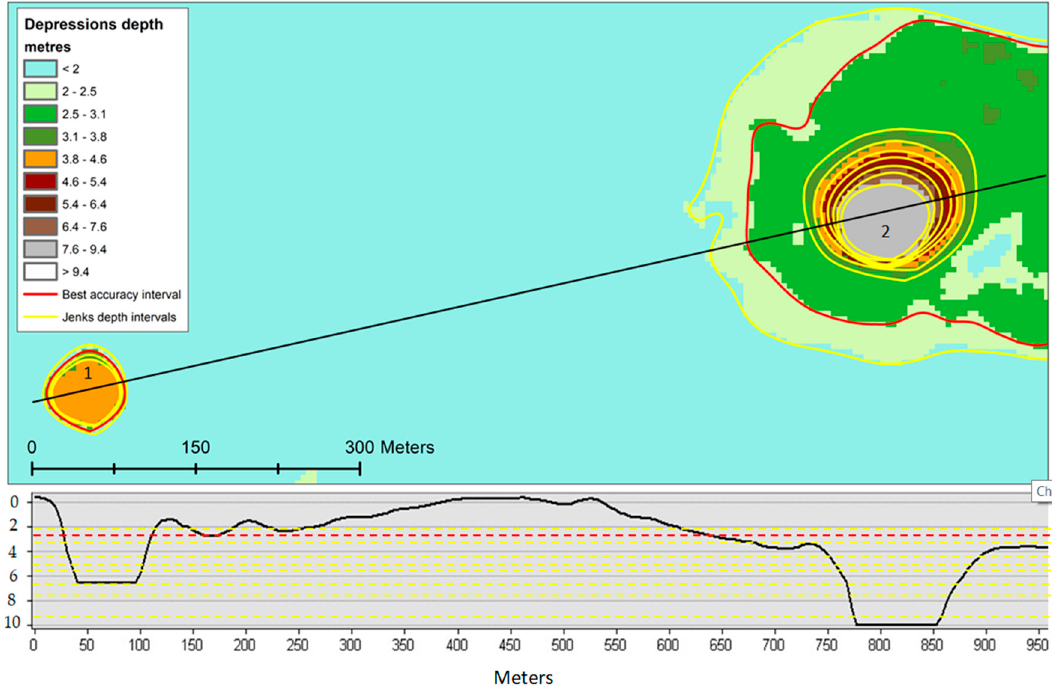
Figure 6. An example of the best-accuracy threshold to define dolines. According scenario 2, the best-accuracy threshold (2.9-m depth) is appropriate to delineate depression 1 but fails to map a doline contained in depression 2 since its shape, at this given depth, is highly irregular to be categorized as a doline. Notice the multiple contours, Jenks classes with estimated thresholds depth, surrounding dolines (in yellow), supporting the implementation of the MDTA and a depressions-containing depression (DCD) filter. Depth in the profile figure was exaggerated to visualize dolines. Table 1. Single thresholds derived from Jenks base 2 and results of the MDTA with DCD filter performance (scenario